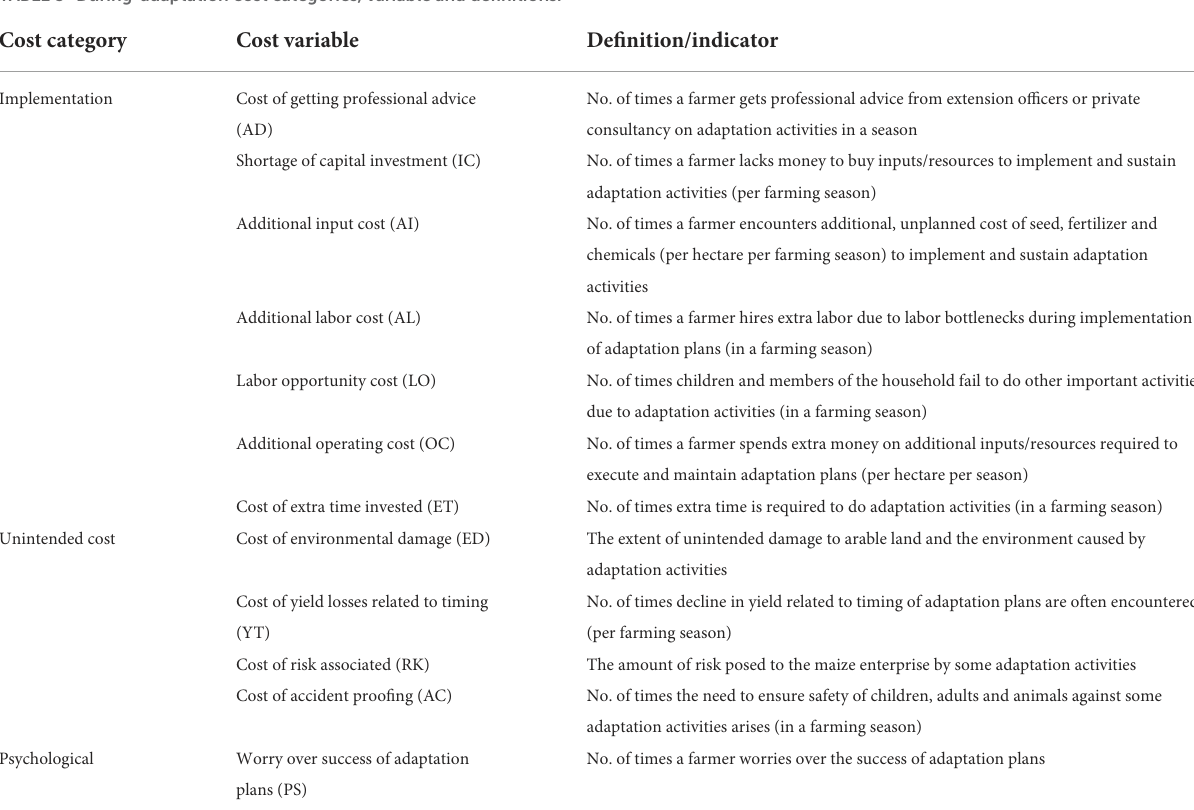
TABLE 3 During-adaptation cost categories, variable and